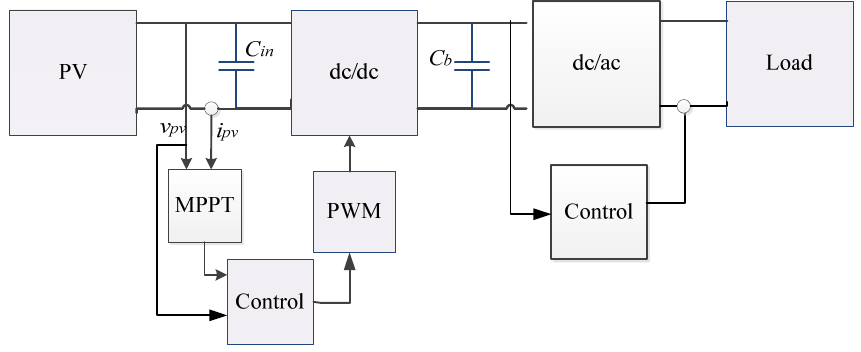
Figure 2. Structure of a PV system with a classical pulse width modulation ( PWM)-based cascade control.